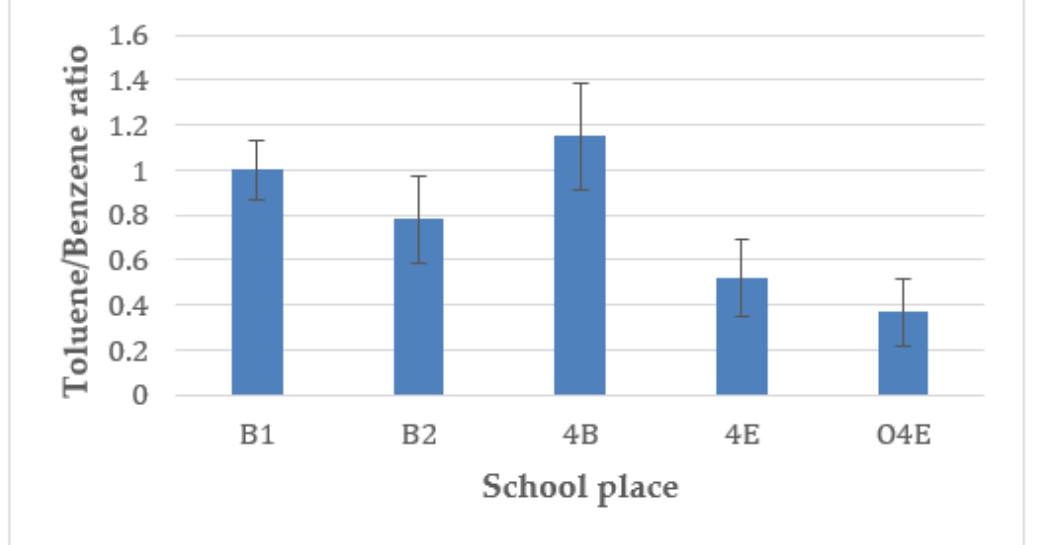
Figure 7. Toluene/Benzene ratio in the monitored school areas. B1, indicates the male bathroom site; B2, the female bathroom site; 4B, classroom 4B; 4E, classroom 4E; and O4E, the external balcony of classroom 4E.